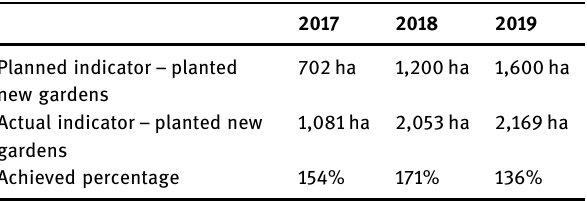
Table 2: Plant the Future – planned and actual indicators